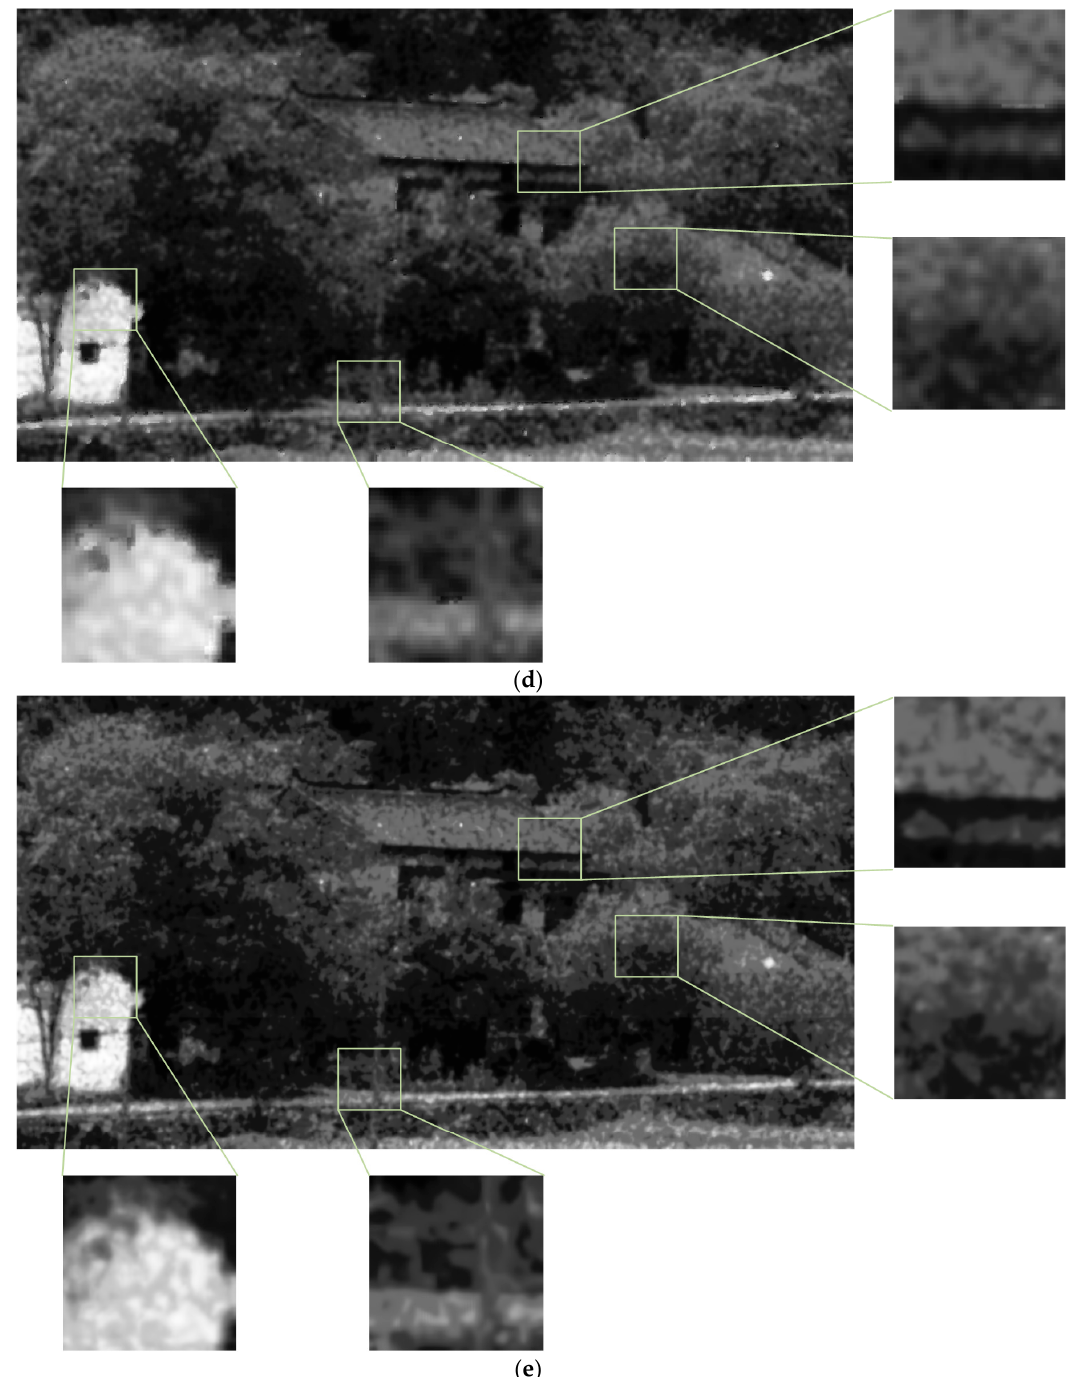
Figure 9. The subjective results of the proposed scheme and others. ( a ) a real ICCD sensing image; ( b ) the result of the proposed scheme; ( c ) the result of BM3D; ( d ) the result of the denoising method based on the K-SVD; ( e ) the result of BLS-GSM.